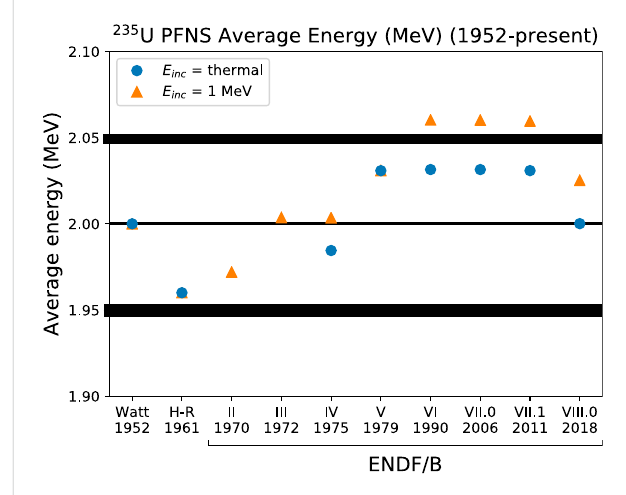
The evaluated PFNS fi ssion average energy for 235 U, in databases from 1952 — present. Thermal incident neutron data are shown as solid blue symbols, whereas 1 MeV incident energy values are orange triangles.The Hansen and Roach evaluation[31]from LosAlamosis denoted H-R. The horizontal line show ENDF ’ s value today, for thermal neutrons. (Credit: N. Gibson).